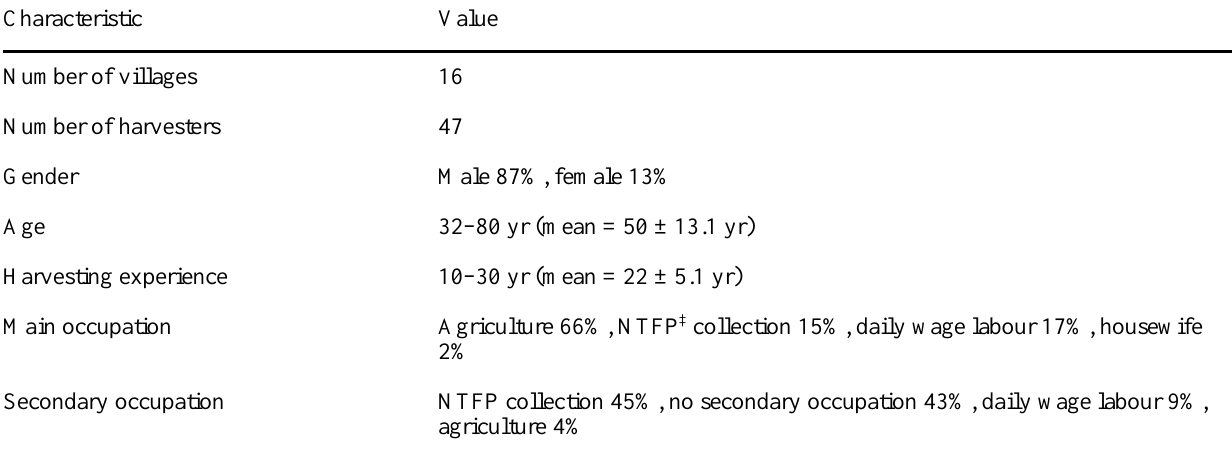
Table 1. Characteristics of the interviewed harvesters.